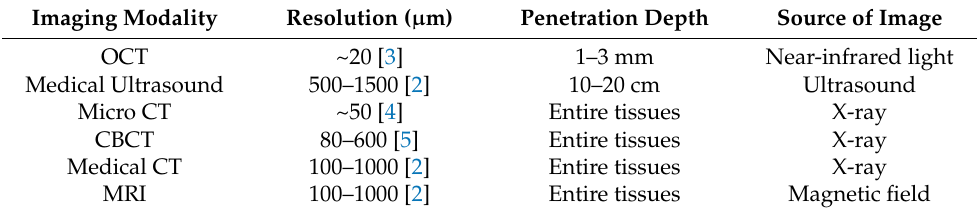
Table 1. Comparison of optical coherence tomography (OCT) and other imaging